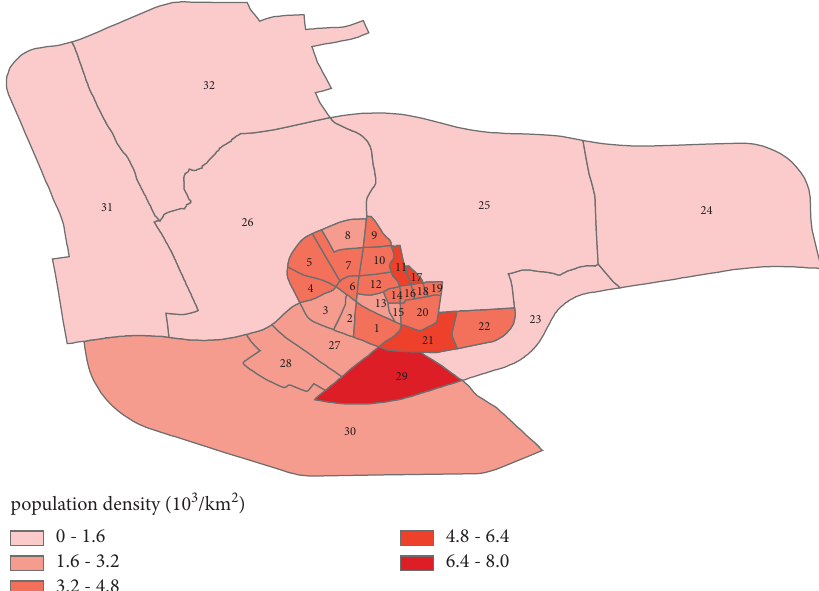
Figure 7: Spatial distributions of population density in Xuancheng, China.